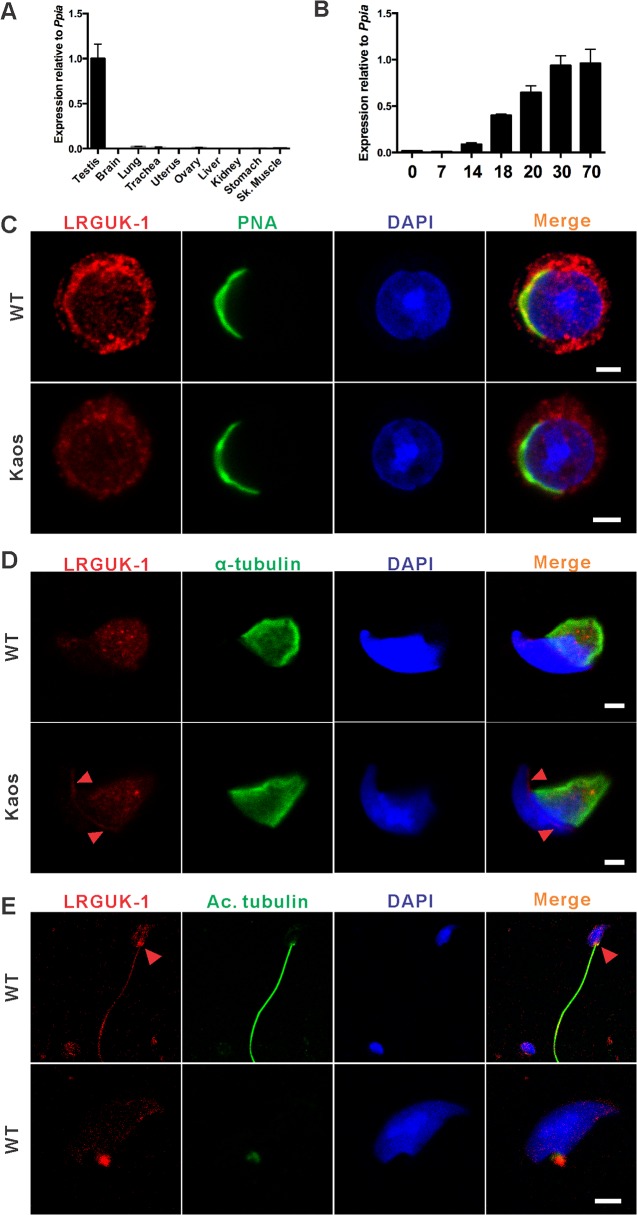
LRGUK-1 is highly expressed in the testis and the localizes to the acrosome-acroplaxoneme-manchette-tail network.(A) Quantitative PCR analysis of Lrguk-1 mRNA expression in various tissues (B) and during the establishment of the first wave of spermatogenesis n = 3. Expression was normalised against Ppia expression and shown as mean±SEM. (C) The localization of LRGUK (red) in purified round spermatids, scale bar = 2μm. Acrosomes were visualised by PNA (green). (D) The localization of LRGUK-1 (red) in purified elongating spermatids, co-labelled with α-tubulin (green) to mark the manchette (scale bar = 2 μm). The red arrowhead indicates LRGUK localization at the leading edge of the acrosome (E) The localization of LRGUK (red) within caudal epididymal sperm, co-labelled with acetylated tubulin (Ac, green) to mark the axoneme (upper panel) and sperm basal body (upper and lower panel). Red arrowheads denote LRGUK localization in the sperm basal body. Scale bar = 4 μm. In all images, nuclei were labelled with DAPI (blue). Please see S3 Fig. for negative control images.